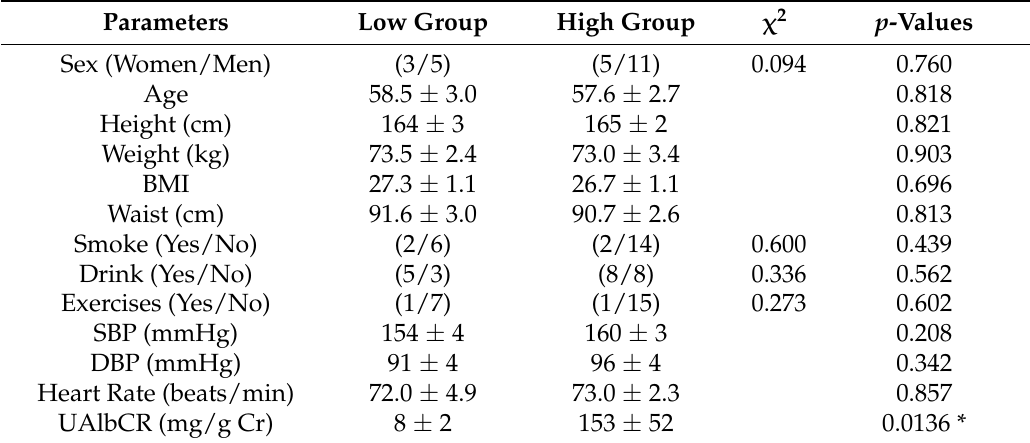
Table 4. Clinical characteristics of the low urinary angiotensinogen (AGT) group and the high urinary AGT group at the baseline.